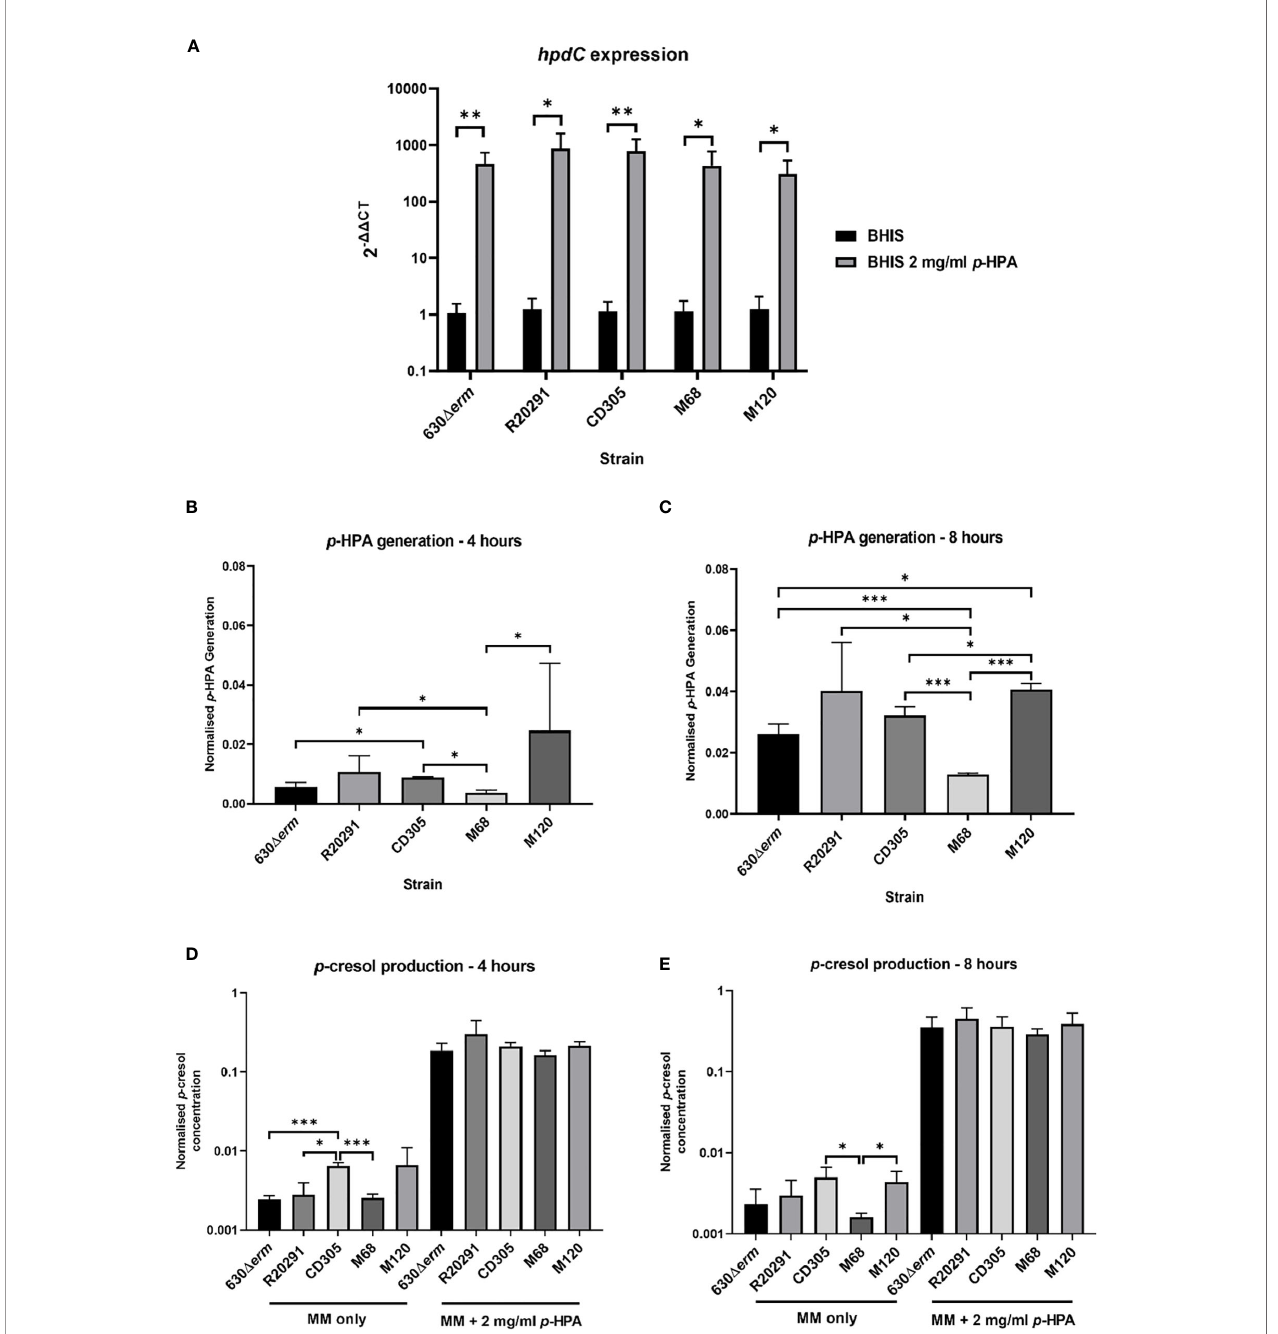
FIGURE 1 | hpdBCA expression, p -HPA, and p -cresol production by strains representing each of the C. dif fi cile clades 1 – 5. (A) qRT-PCR was used to determine whether p -HPA induces the expression of the hpdBCA operon across all fi ve clades of C. dif fi cile . Representative strains 630 D erm (clade 1), R20291 (clade 2), CD305 (clade 3), M68 (clade 4), and M120 (clade 5) were grown to exponential phase (OD 590nm 0.6-0.7) in BHIS ±2 mg/ml p -HPA. The expression was normalized to 16S rRNA control and analyzed by 2 - DD Ct . Data represents the mean of fi ve biological replicates in technical triplicate, and their standard deviation with statistical analysis was carried out by linear regression. The p -HPA and p -cresol concentrations were determined by high-performance liquid chromatography on samples from each strain grown in de fi ned media with or without 2 mg/ml exogenous p -HPA, with samples taken after 4 h (B, D) and 8 h (C, E) . (B, C) p -HPA generation was determined by the addition of p -HPA and p -cresol detected, and (D, E) p -cresol concentration was determined. The concentrations were normalized to growth (by dividing the concentration by the OD 590nm at the time the sample was taken). Data represents the mean and standard deviation of three independent replicates. Statistical analysis was carried out by linear regression and used to determine signi fi cant differences between normalized p -HPA generation and p -cresol concentrations for each strain. Statistically signi fi cant differences are indicated: * p < 0.05, ** p < 0.01, *** p <